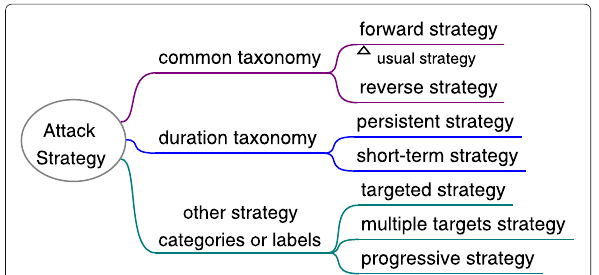
Fig. 9 Taxonomy of social engineering attack strategy